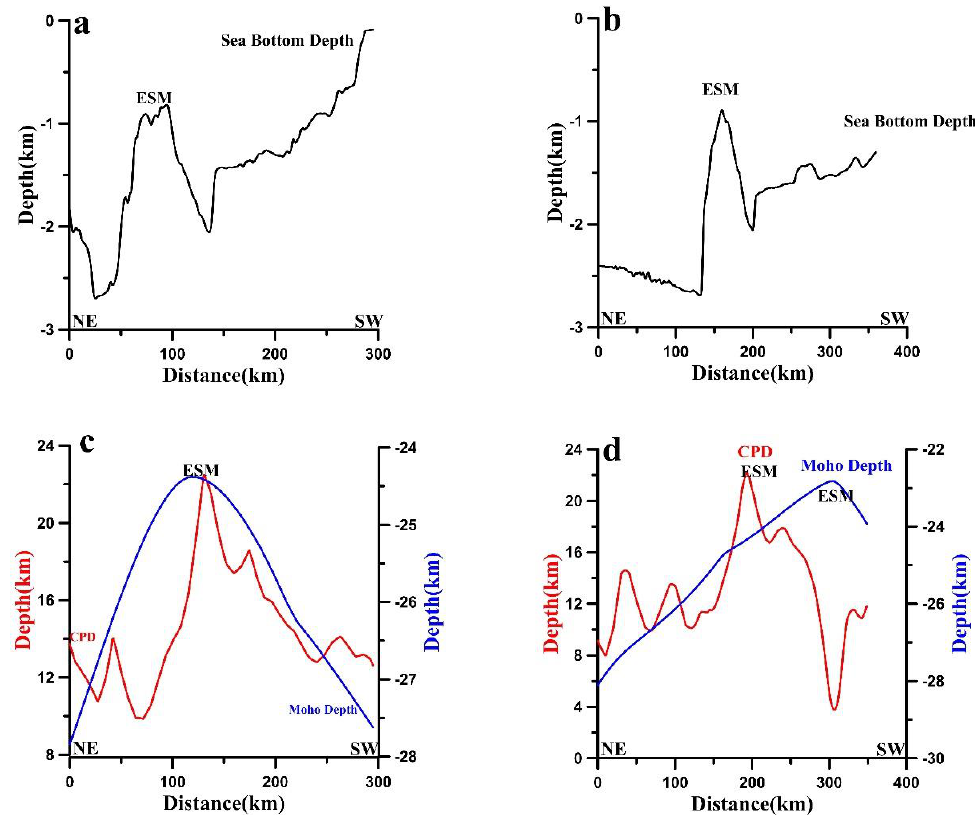
Figure 7. Cross-sections of the CPD map plot along (A) NE-SW and (B) NW-SE directions (profile locations are shown in Figure 5) demonstrating the variation of the Curie point depth, Moho depth and sea bottom depth. ( a ) the sea bottom depth along profile A, ( b ) the sea bottom depth along profile B, ( c ) Moho depth (blue color), CPD (red color) along profile A and ( d ) Moho depth (blue color), CPD (red color) along profile B.